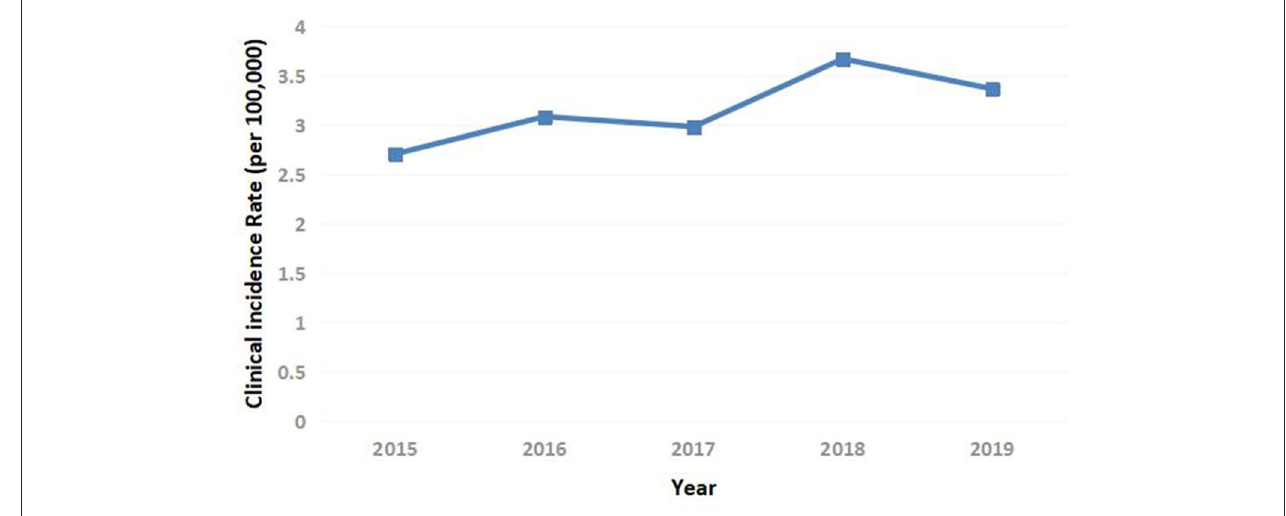
FIGURE 1 | Clinical incidence of T1DM in children and adolescents in China.